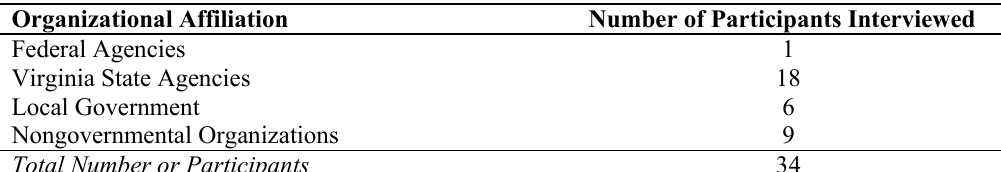
Table 2: Participants Interviewed based on Organizational Sector